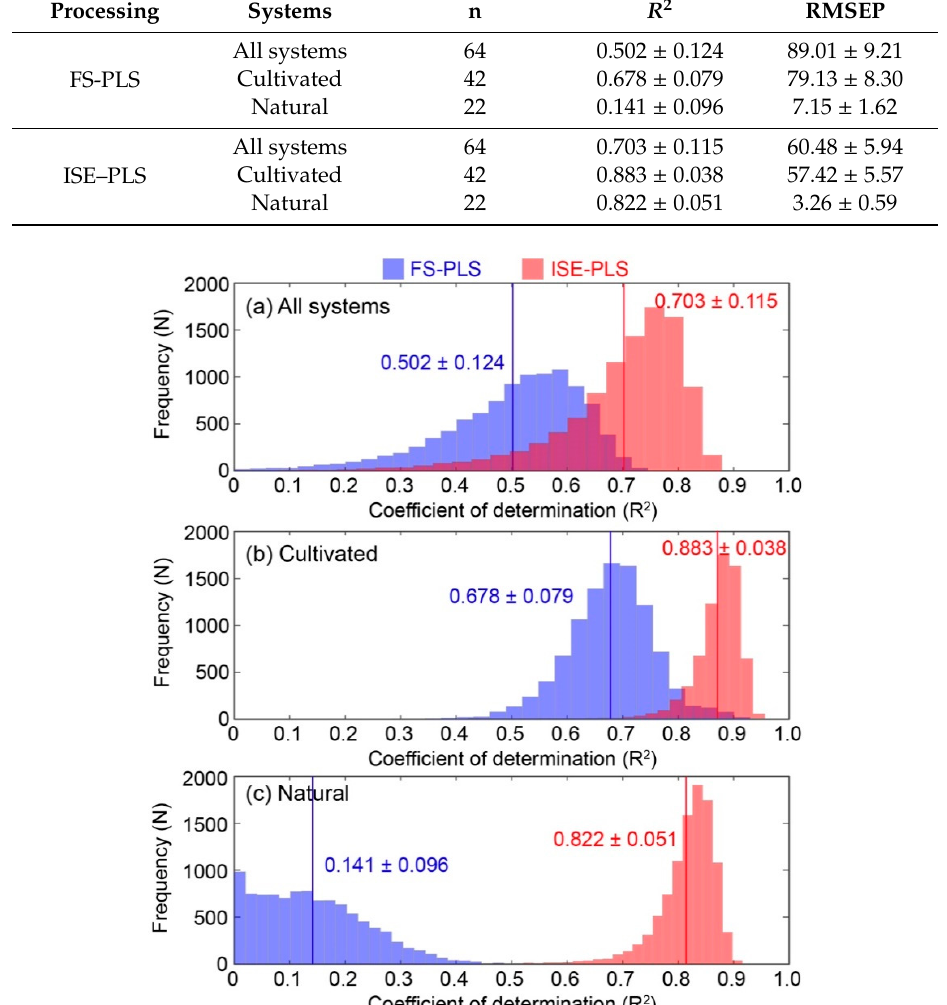
Figure 6. Comparisons of the frequency distributions of R 2 values in the test data for each system: ( a ) all systems; ( b ) cultivated; ( c ) natural using FS-PLS and ISE–PLS models, with mean (red and blue line) ± standard deviation (SD) values.